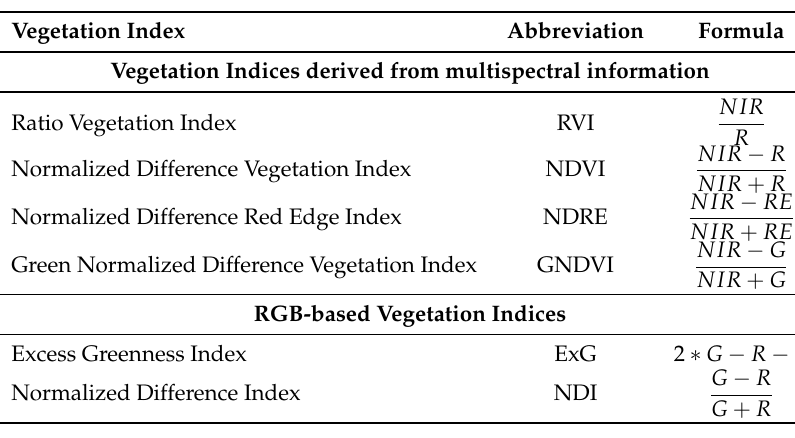
Table 3. Most used vegetation indices.